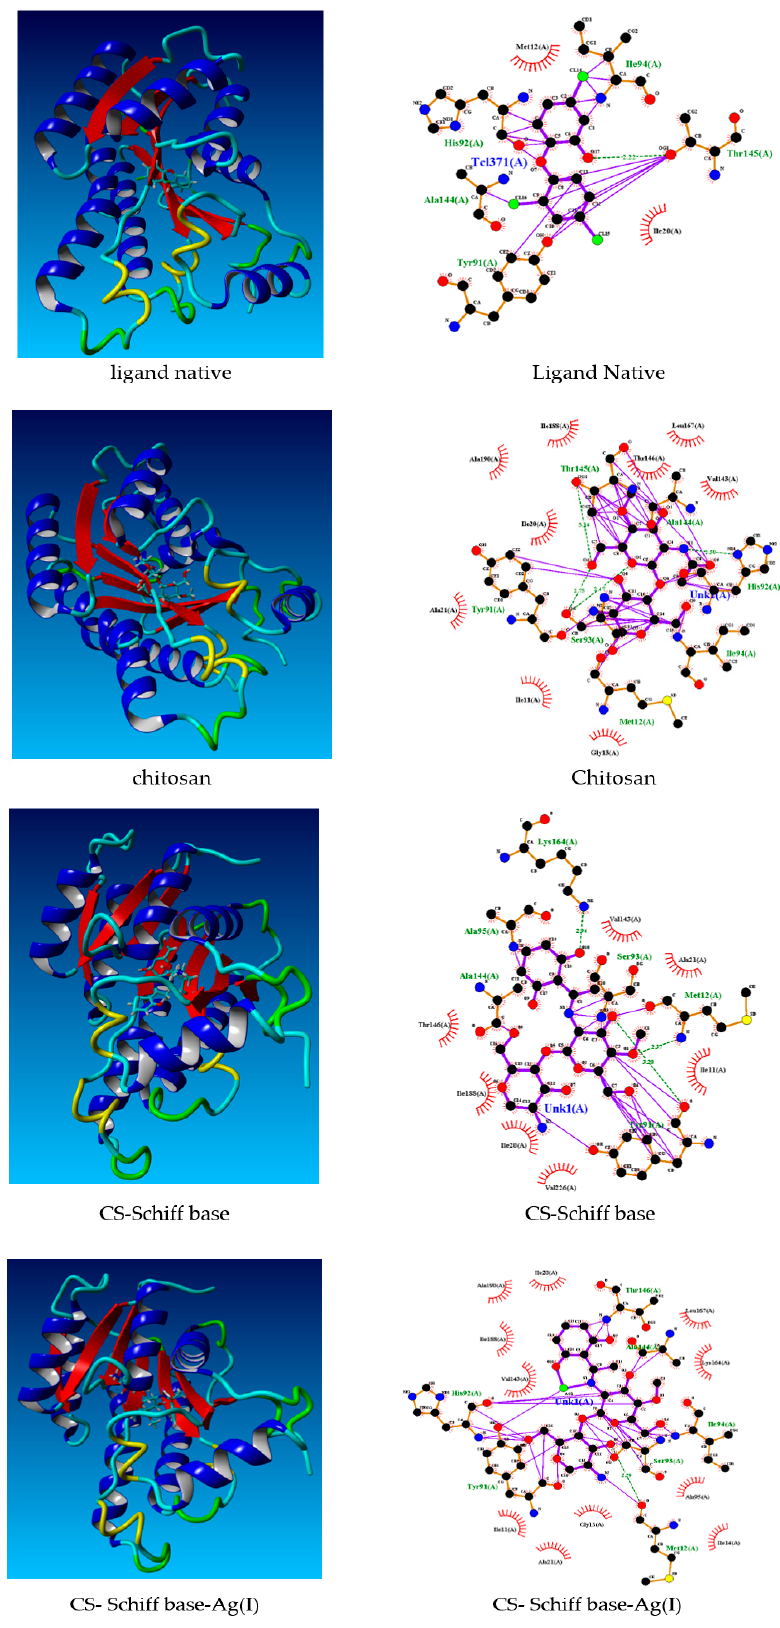
Figure 11. Docking conformation and bonding interactions of native ligand, chitosan, CS-Schiff base and CS-Schiff base-Ag(I). Table 6. The interaction of Staphylococcus aureus amino acids with various compounds.